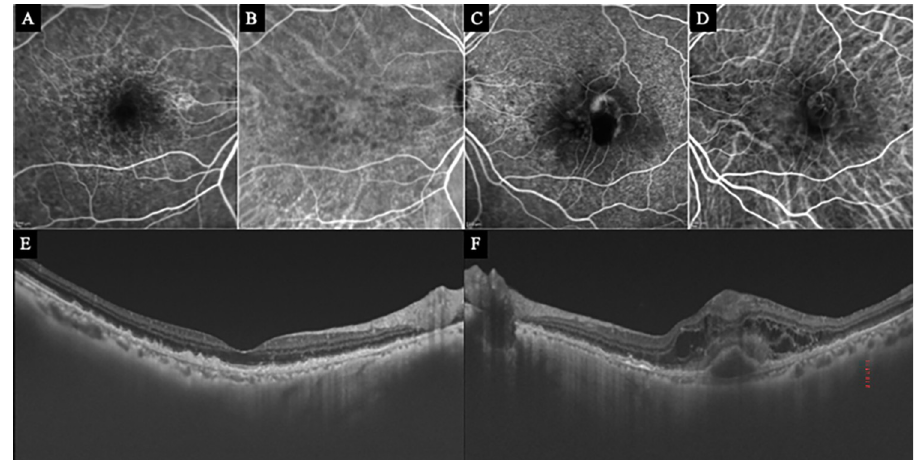
Fig 4. Baseline findings in Case 5 with a type 3 MNV in the left eye. A type 3 MNV developed in the fellow normal right eye during the follow-up period. Top row: FA and ICGA of the right (A and B) show no abnormalities. FA of the left eye (C) shows leakage in the superotemporal region of the fovea. The findings in the temporal fovea could not be confirmed because of blockage by intraretinal hemorrhage. ICGA image of the left eye (D) shows hyperfluorescence as hot spots corresponding to the leakage of FA. Bottom row: OCT image of the right eye (E) has no abnormality other than RPE irregularities due to drusen. OCT image of the left eye (F) shows cystoid macular edema, PED, and intra- and sub-retinal hyperreflective tissue associated with the hemorrhages.